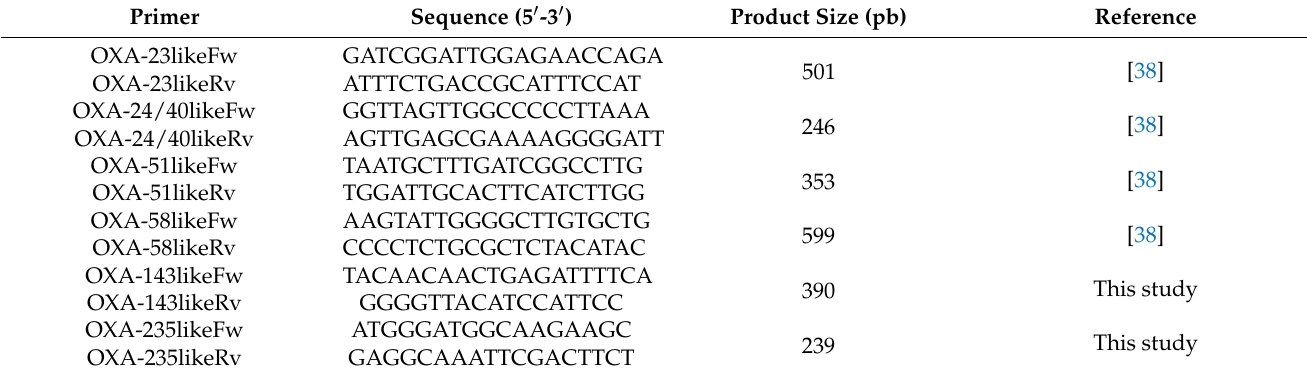
Table 6. Primers used in the